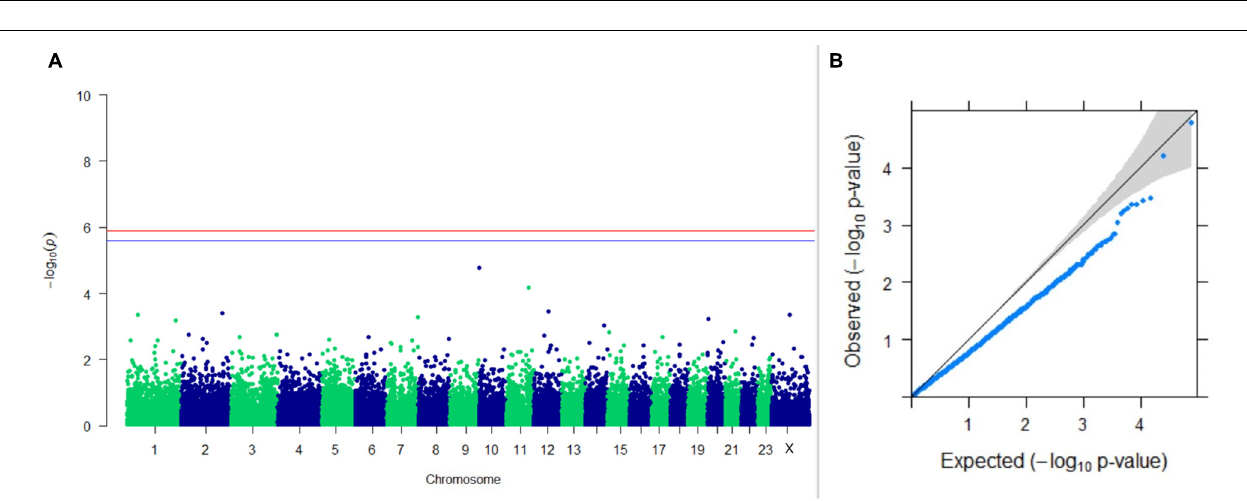
FIGURE 13 | Results of GWAS for postpartum breeding interval. (A) Manhattan plot of genome-wide SNPs. The red line indicates the p- value threshold (expressed as –log 10 P ) corresponding to FDR-corrected p- values or q = 0.05, above which the SNPs are considered to be significantly associated with the trait, while the blue line indicates the genome-wide suggestive threshold at q = 0.1. The SNPs identified on chromosome no. 24 were screened out from analysis because of stringent quality control; hence, it is not represented in the Manhattan plot. (B) Q-Q plot of the p- values.